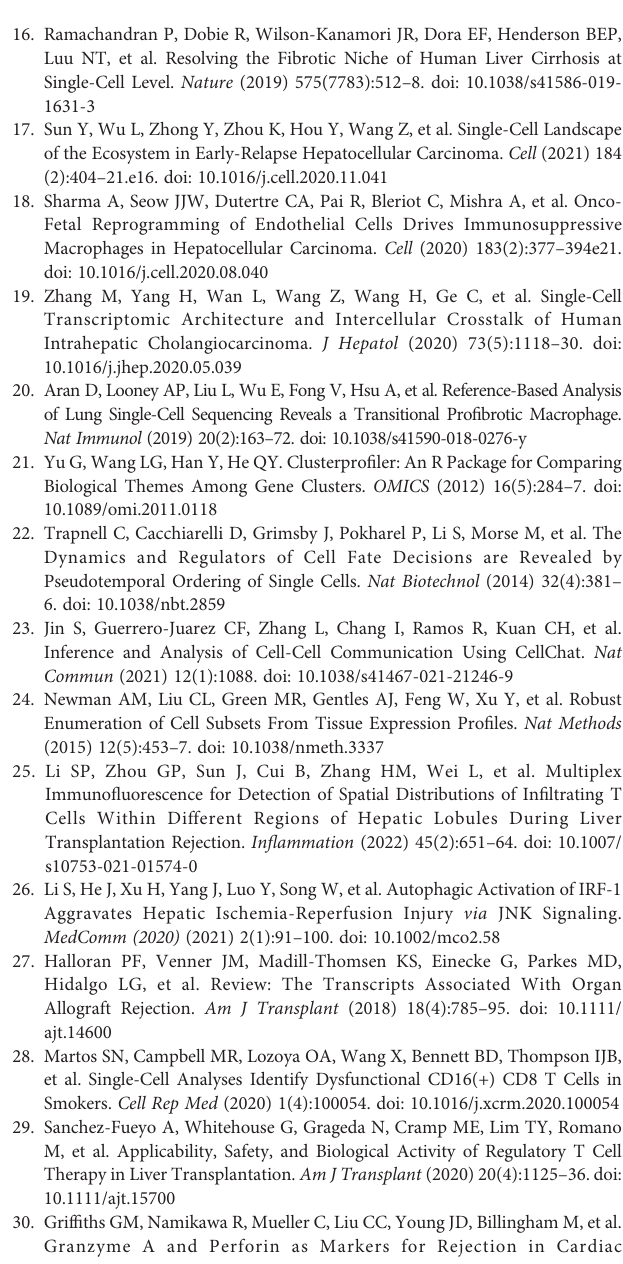
proportion of CD8+ T cells among stable (N, n=129) and rejection (R, n=37) samples after liver transplantation using CIBERSORT algorithm. Supplementary Figure 6 | The multi-lineage communication patterns and inferred signals between LDLR+ macro and T cells. (A) Outgoing communication patterns of secreting cells (left) and incoming communication patterns of target cells (right). (B) Dotplots showing the interactions between LDLR+ macro cells and T cells in liver transplantation (left). The distribution and contribution of NECTIN signaling pathway network (right). Supplementary Figure 7 | Enrichment analysis of KEGG terms for differentially expressed genes in LDLR+ MDSC. (A) Enrichment analysis of GO terms for differentially expressed genes in LDLR+